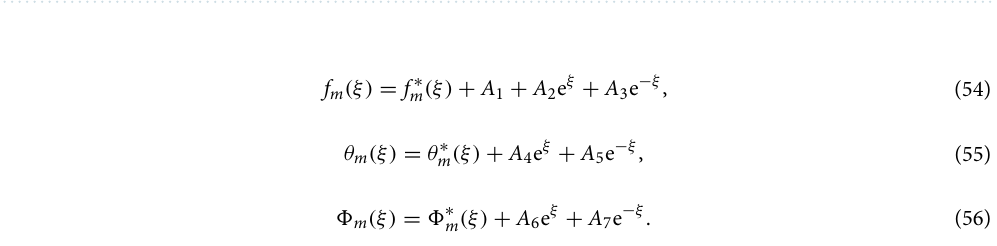
Figure 3. The fluctuation in velocity f values of Ŵ